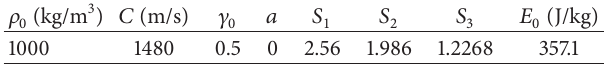
Table 1: Parameters in Mie-Gruneisen EOS for water [20].